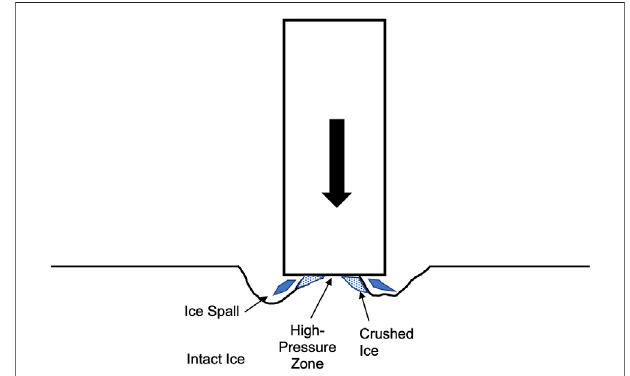
FIGURE1| Schematicofice-indentationprocessesastheyoccurunder a narrow indenter, based on concepts by Gagnon and Molgaard (1991), Jordaan(2001) and Wellset al.(2011). Similar processes might occur at slider or ice